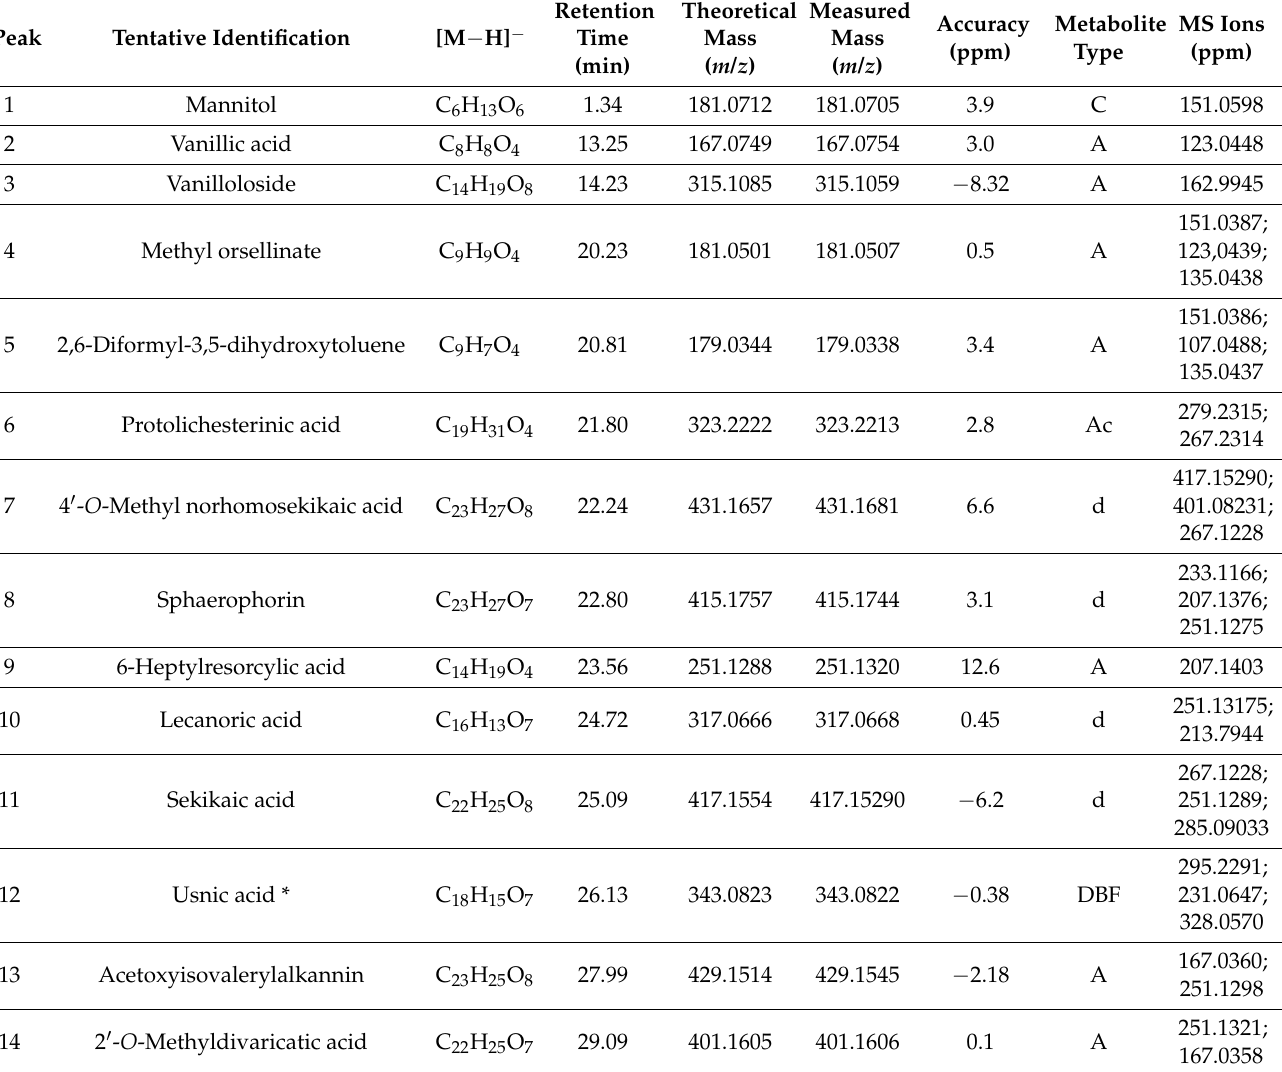
Table 3. Identification of metabolites in Sphaerophorus globosus by UHPLC-QTOF-MS-MS.